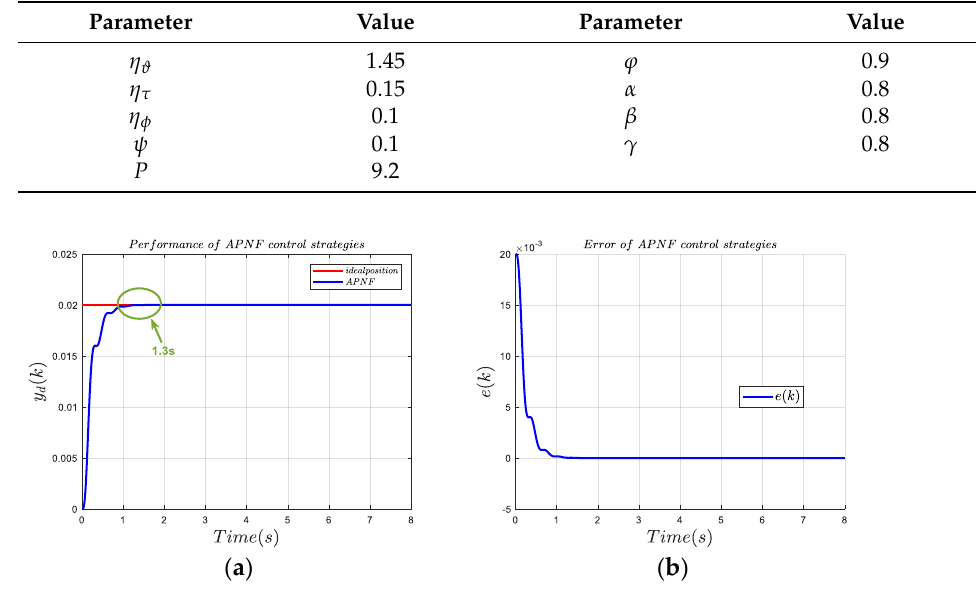
Figure 7. ( a ) Response performance curve of the APNF control system; ( b ) response performance error curve of the APNF control system.